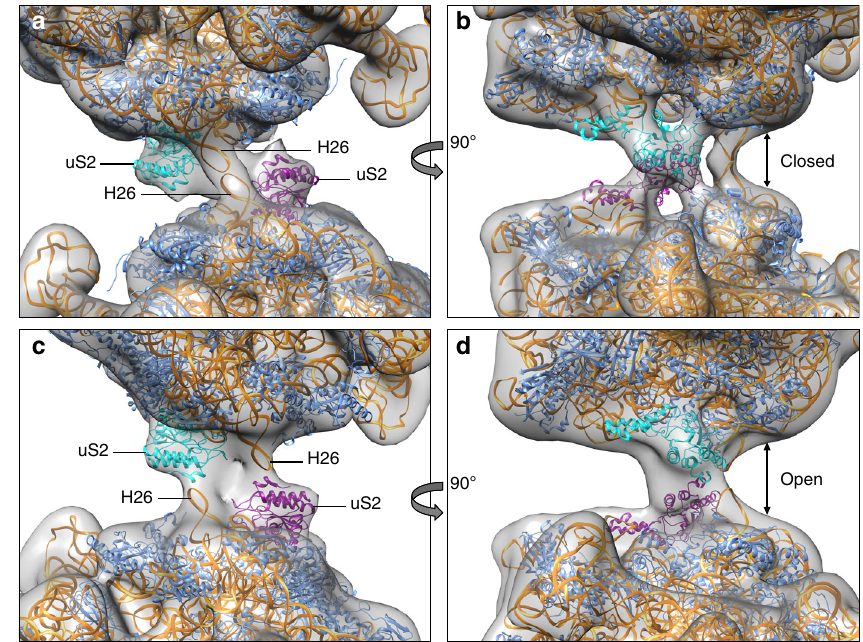
Fig. 3 Different conformational states of 100S ribosomes. Rigid-body fi ts of two 70S models without the C-terminal domains of HPF long into the low-resolution maps of the two most extreme conformations, closed state ( a , b ) and open state ( c , d ). The difference between the two classes depicts a 55° rotation around the interface. The ‘ closed ’ conformation closely resembles our 5.6 Å map. Colors indicate 16S rRNA ( orange ), protein uS2 ( cyan and purple ) and other proteins ( blue ). The rotation causes H26 to change its interaction from H26 to protein uS2 from the other ribosome, effectively widening the space between the two 70S ribosomes within the dimer ( arrows in b , d )